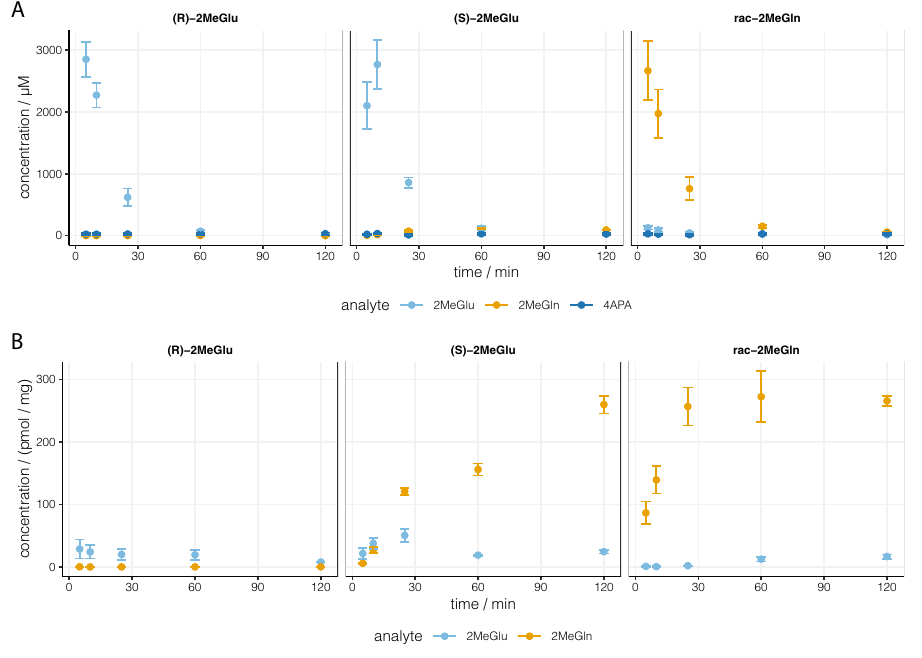
Figure 5. Pharmacokinetics of 2Me compounds and their metabolites measured in mouse serum ( A ) and brain ( B ) after IP injection of 100 mg/kg of test compounds (in columns). Concentrations are expressed per volume in the serum samples and per protein content in the brain samples. Data are shown as mean ± SEM, n =